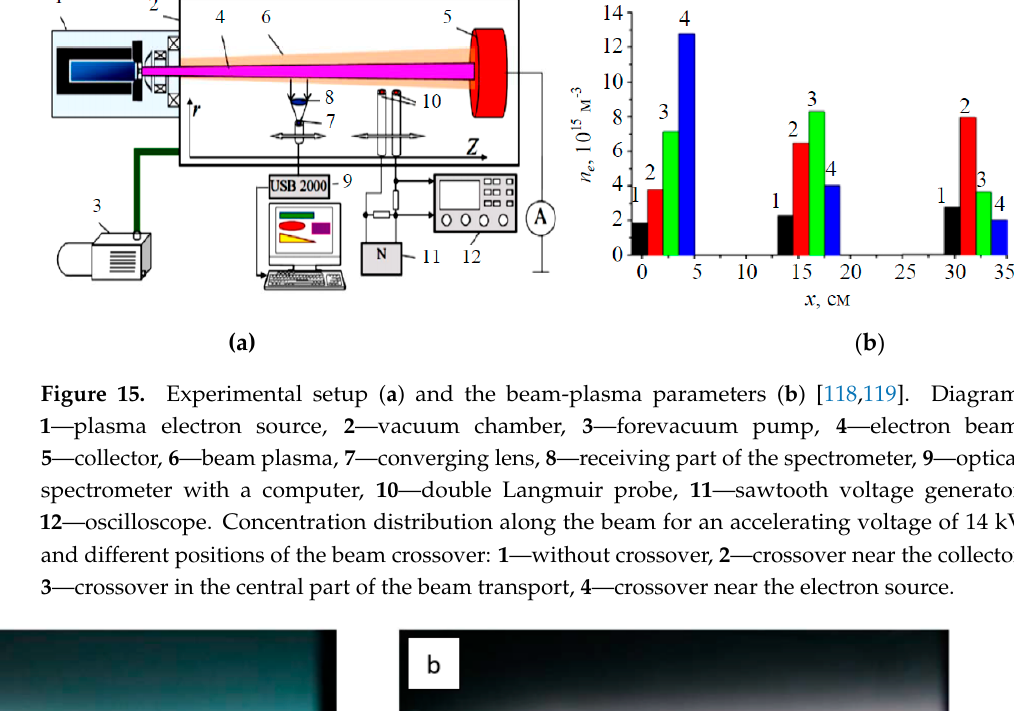
Figure 15. Experimental setup ( a ) and the beam-plasma parameters ( b ) [118,119]. Diagram: 1 —plasma electron source, 2 —vacuum chamber, 3 —forevacuum pump, 4 —electron beam, 5 —collector, 6 —beam plasma, 7 —converging lens, 8 —receiving part of the spectrometer, 9 —optical spectrometer with a computer, 10 —double Langmuir probe, 11 —sawtooth voltage generator, 12 —oscilloscope. Concentration distribution along the beam for an accelerating voltage of 14 kV and different positions of the beam crossover: 1 —without crossover, 2 —crossover near the collector, 3 —crossover in the central part of the beam transport, 4 —crossover near the electron source.